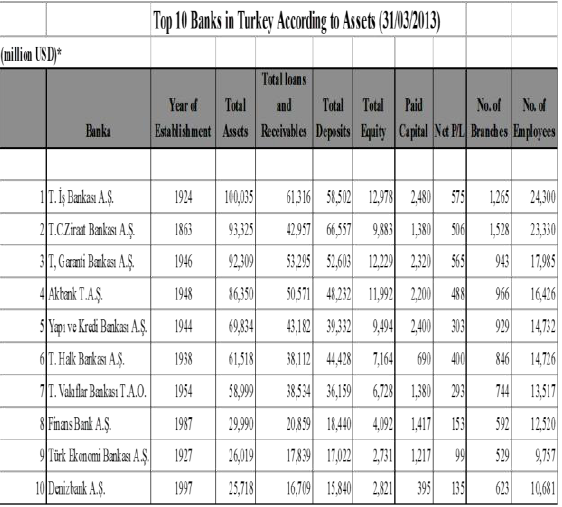
Source: The Banks Association of Turkey (2014), * Figures